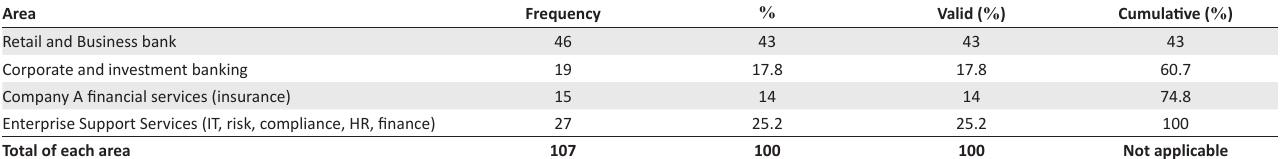
TABLE 4: Percentage response from each division of Company A. Area